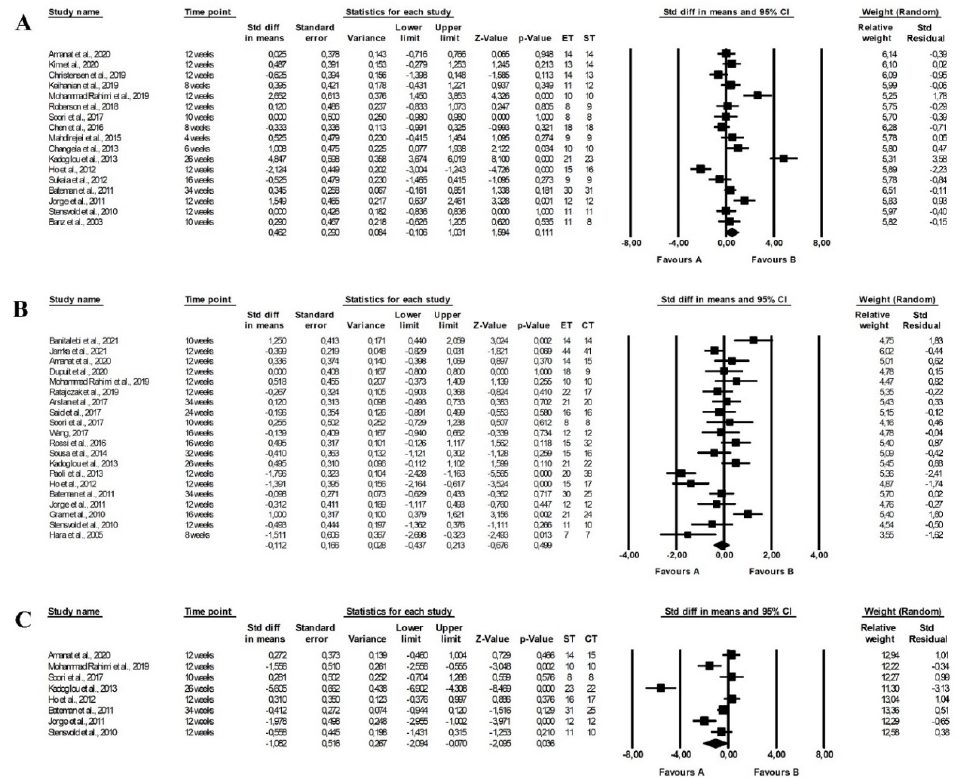
Figure 11. Forest plots of the effect of training programmes on high-density lipoprotein cholesterol levels: ( A ) endurance (favours A) vs. strength (favours B) training (random model) [13,14,22,41,43– 46,49,55,57,61,63,66,68,69,73]; ( B ) endurance (favours A) vs. endurance-strength (favours B) training (random model) [13,21,22,37–39,41,46,47,52,54–56,60,63,64,66,69,70,72]; ( C ) strength (favours A) vs. endurance-strength (favours B) training (random model) [13,22,41,46,55,63,66,69]. CI—confidence interval; CT—combined training; ET—endurance training; ST—strength training; Std—standard; Std diff—standard